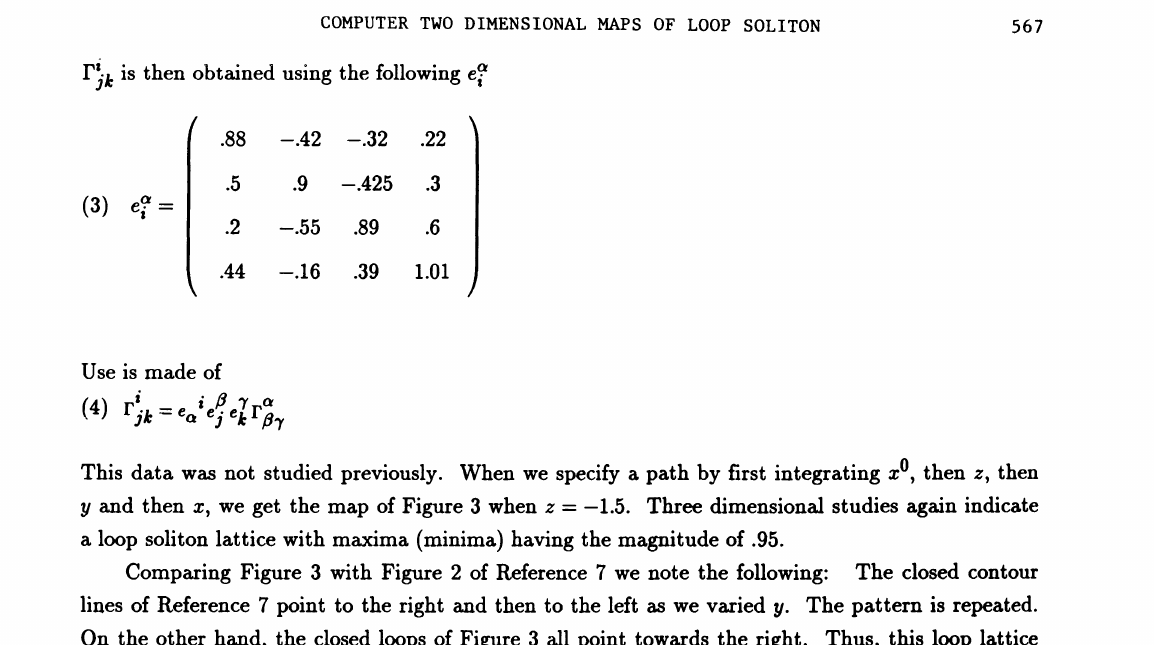
Comparing Figure 3 with Figure 2 of Reference 7 we note the following: The closed